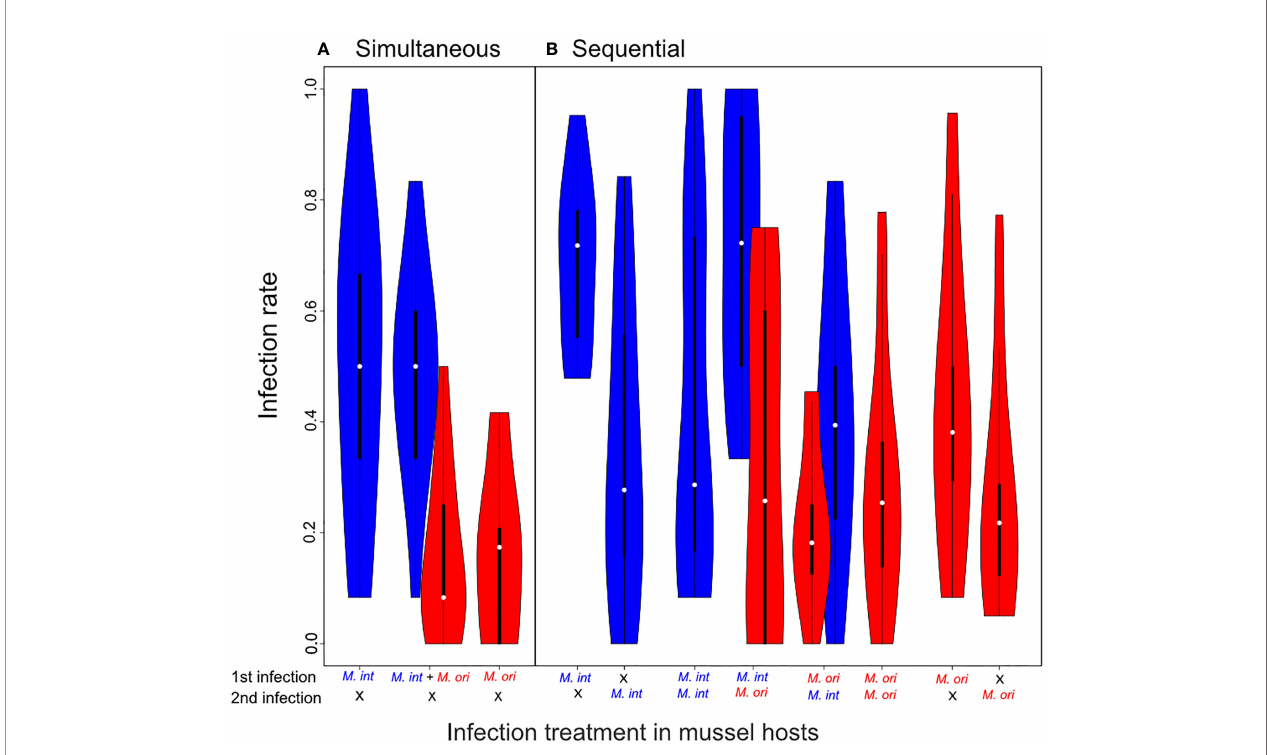
FIGURE 4 | Infection rates of simultaneous infections and sequential infections. Violins show the range of the observed data with violin width representing the frequency distribution of values. Box and whiskers give the 50 and 95 percentile, and white dots within boxes show the median. (A) In simultaneous infections the only signi fi cant difference observed was the lower infection rates of Mytilicola orientalis (red) compared to Mytilicola intestinalis (blue), which was consistent between infection types (see Table 1A ). Post-hoc tests between all groups showed the between-species comparisons were all signi fi cant (P < 0.001), whereas the within- species comparisons were not ( p > 0.99). (B) Similarly, M. orientalis had signi fi cantly lower infection rates in sequential infections. Additionally, infection rates were on average lower in the second round of infection. This difference was however mainly driven by M. intestinalis infections, whereas there was no signi fi cant difference in M. orientalis infections (see Table 1B ). Pairwise comparisons between single infections to the corresponding infection rates in hetero-speci fi c infections showed no signi fi cant difference (all p -values > 0.9), indicating that between parasite interactions did not alter the outcome of infections. Infection rates resulting from the same species in both rounds were combined into one